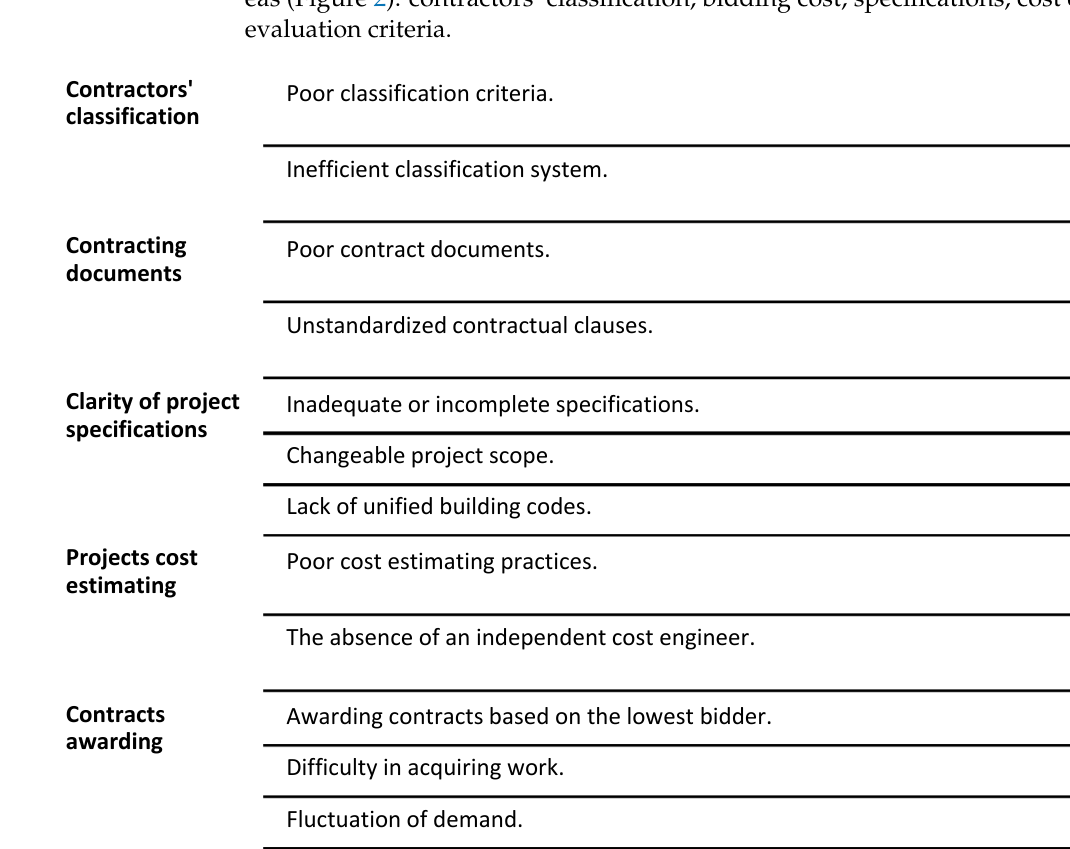
Figure 2. The most frequent impediments related to the tendering phase.